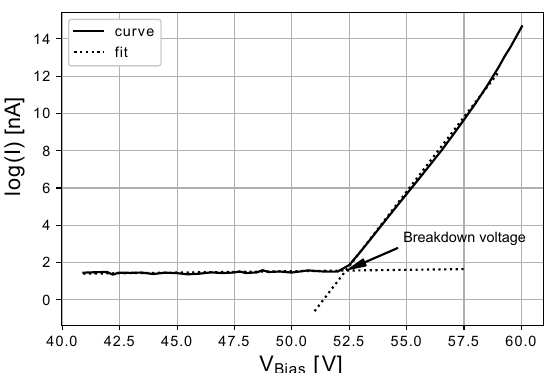
current vs bias voltage) curve and the baseline. Figure 3 shows the SiPM IV curve at 25 ◦ C where the V br was at ∼ 52.3 V.